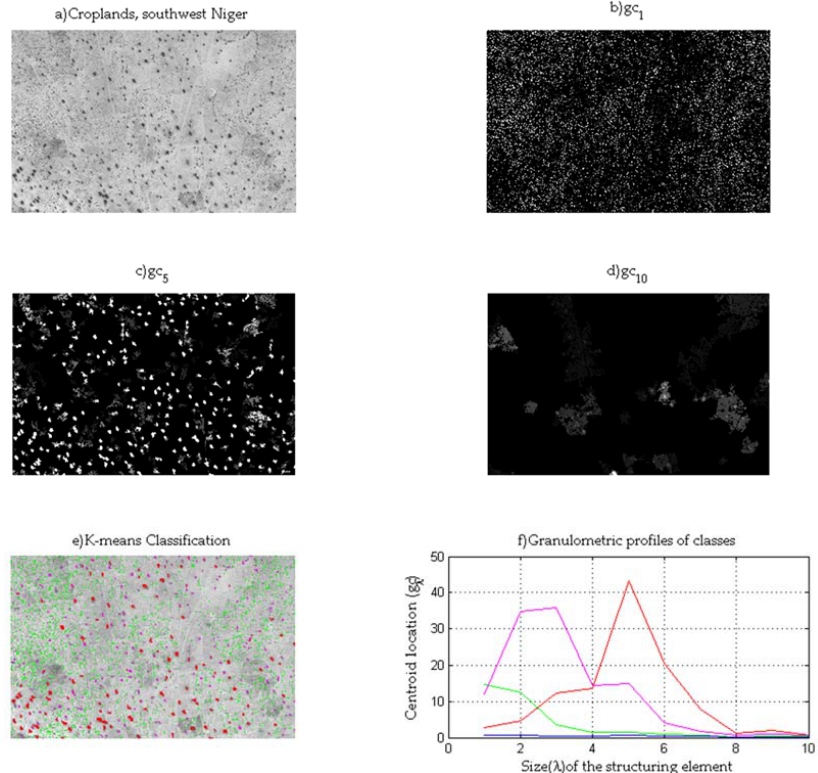
Figure 1. Steps performed to map the ligneous cover by means of unsupervised classification of morphological profiles. ( a ) Original grey tone image; ( b ) Granulometric density for a SE of size 1; ( c ) Granulometric density for a SE of size 5; ( d ) Granulometric density for a SE of size 10; ( e ) k-means classification in 4 classes from granulometric profiles; ( f ) Granulometric profiles for each class.